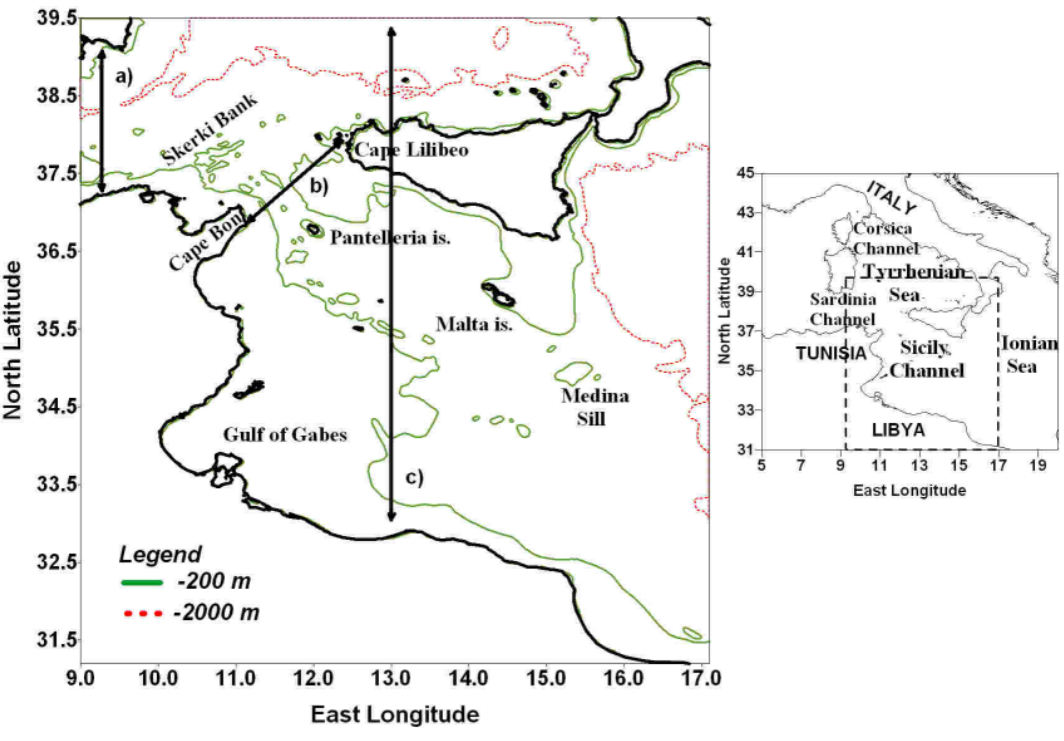
Fig. 1. Morphology of the Central Mediterranean Sea. Isolines indicate the 200m and the 2000m countours. a), b) and c) indicate the vertical sections at 9 ◦ E, at the Sicily Strait and along longitude 13 ◦